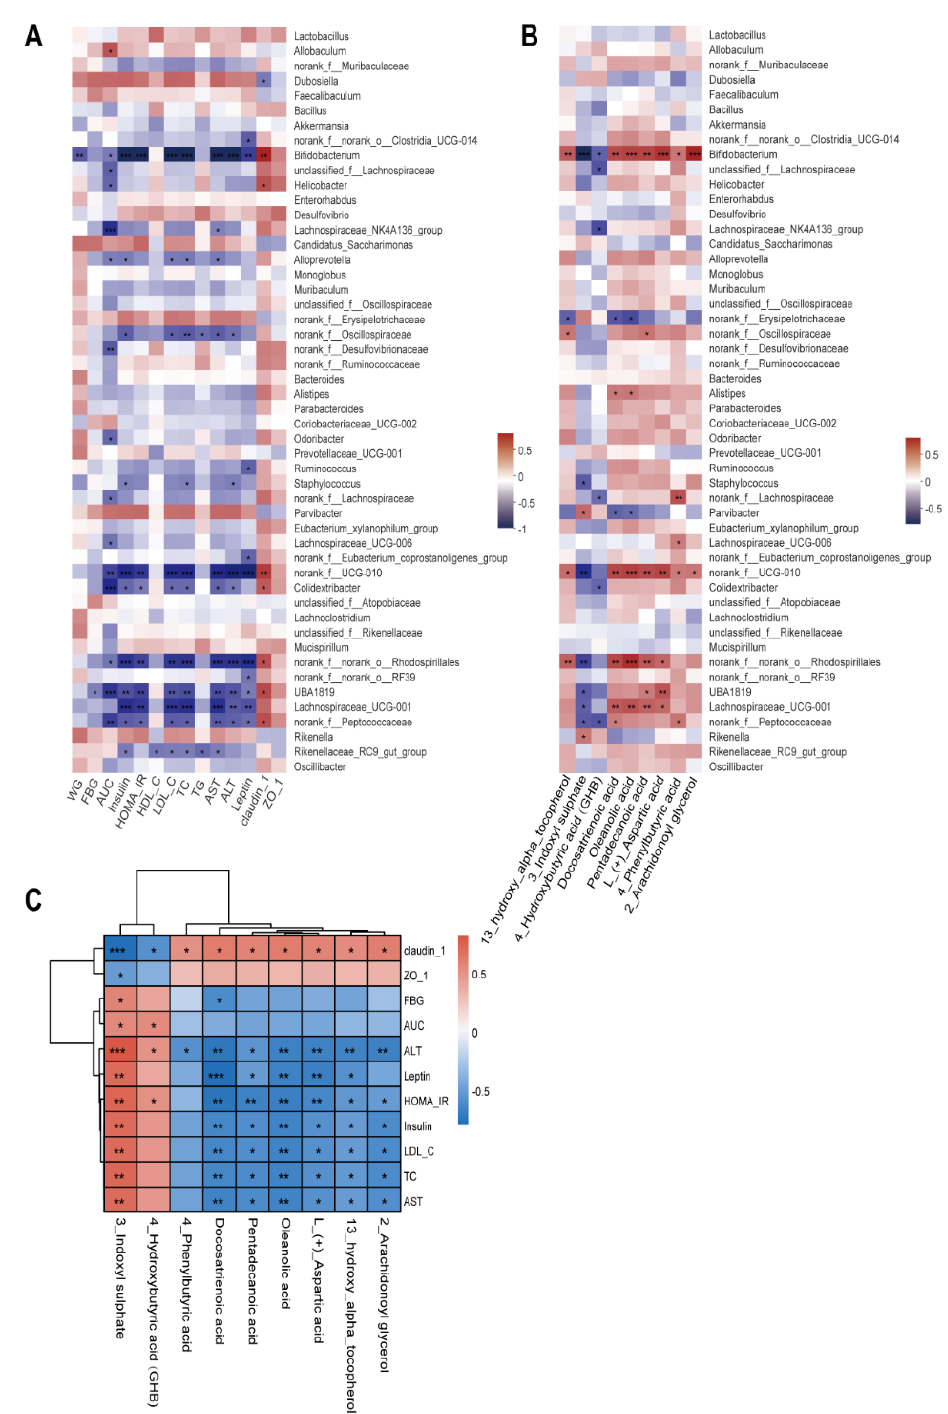
Figure 6. Correlation analysis of gut microbiota, fecal metabolites, and glucose and lipid metabolism indexes: ( A ) Heatmap of correlations between metabolic parameters and the top 50 genera in gut microbiota abundance, ( B ) Heatmap of correlations between nine important differential fecal metabolites and the top 50 genera in gut microbiota abundance, ( C ) Heatmap of correlations between metabolic parameters and important differential fecal metabolites. The legend on the right is the color range for different R values, red for positive correlation and blue for negative correlation. (* p < 0.05, ** p < 0.01, *** p < 0.001).